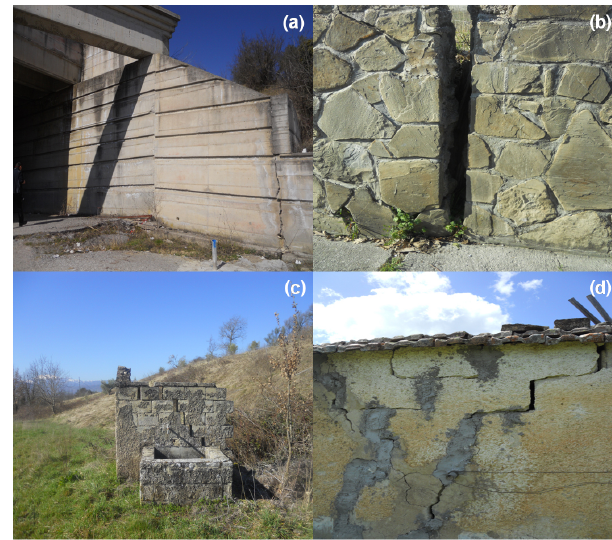
Figure 10. Evidence of deformation and warping on the road tunnel (a) , retaining walls (b) , and old building (c–d) .